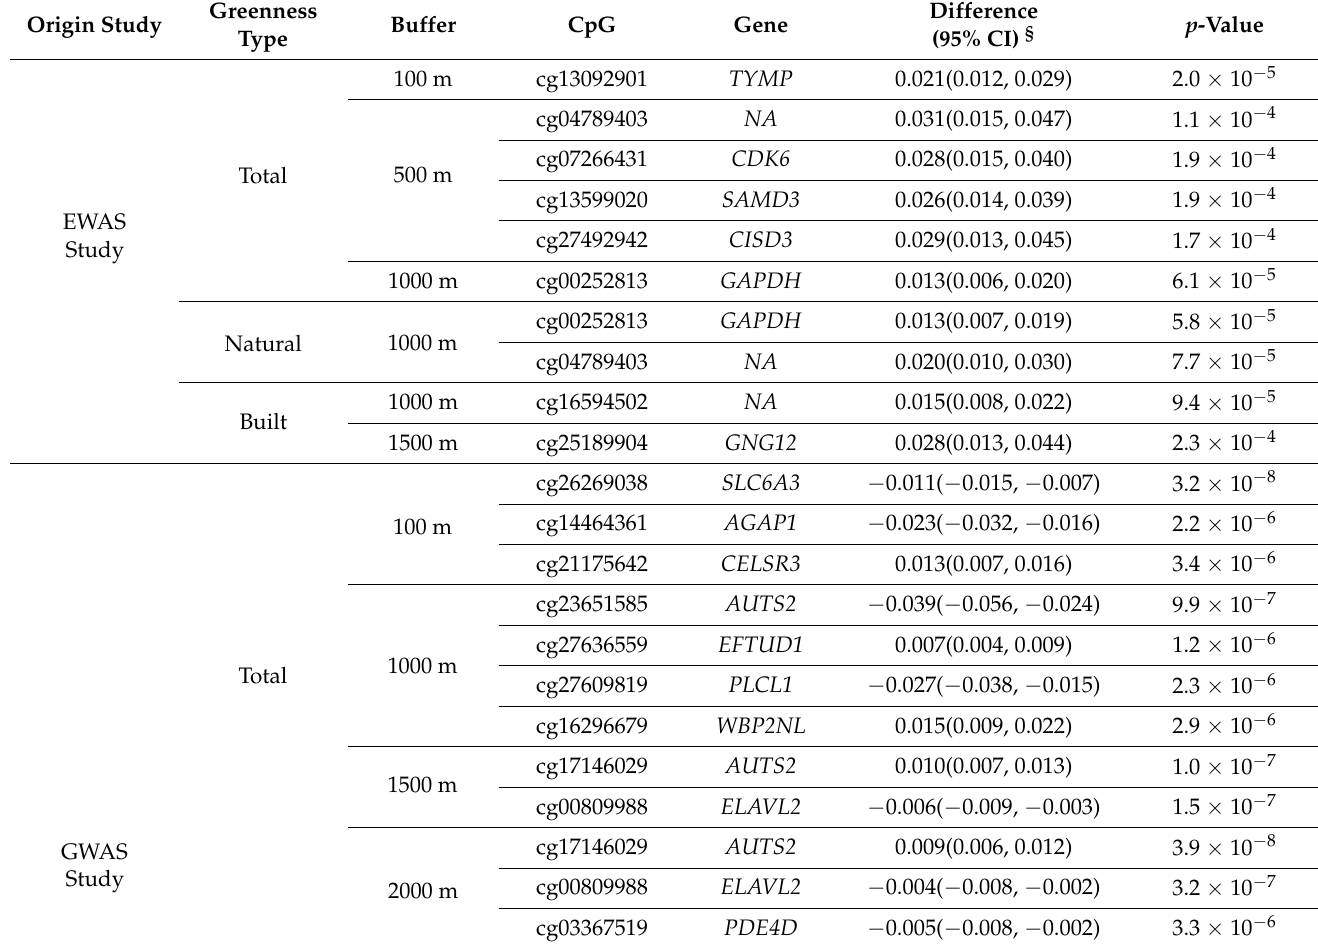
Table 2. The significant relationship between greenness exposure and selected DNAm at age 2 † . Origin Study